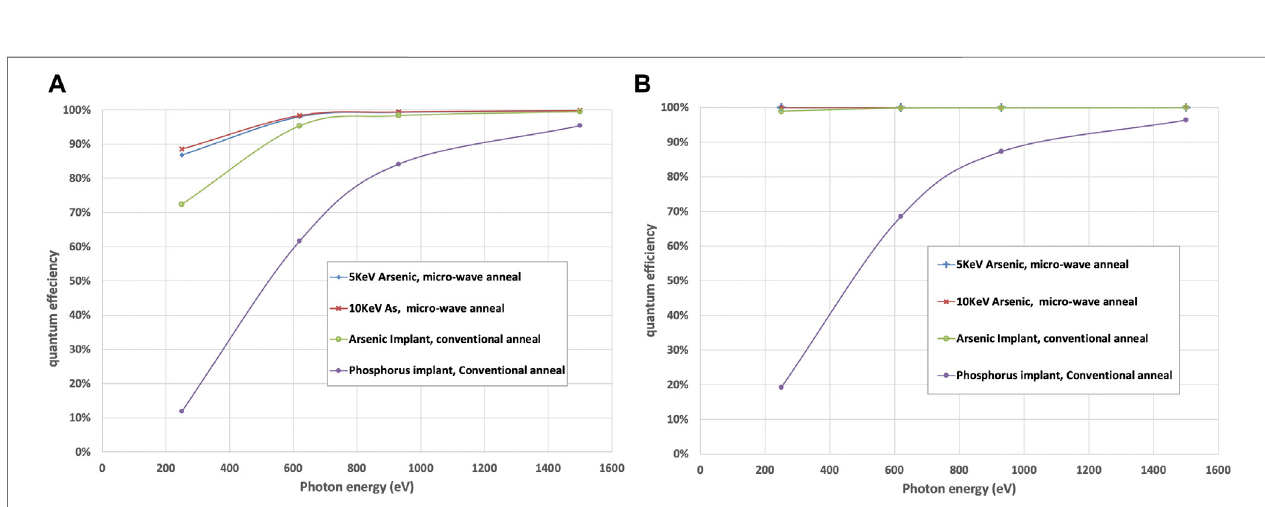
FIGURE12| Simulatedquantumef fi ciencyforentrancewindowwith (A) metalcontactedentrancewindow,and (B) oxideinterfacefor250,619,930and1500 eV photons, based on percentage absorption shown in Figure 10 . Losses from photon absorption in metal or oxide layers are not included in the calculations.